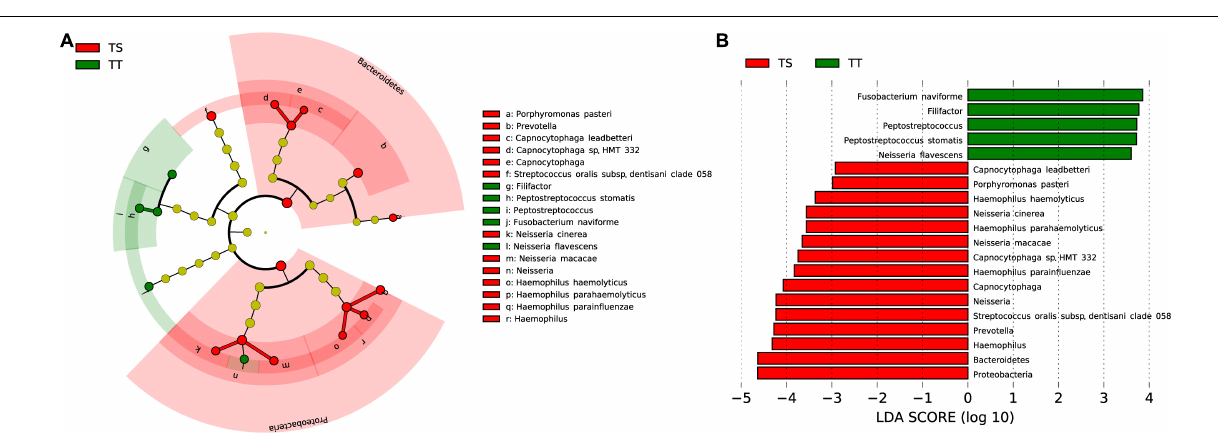
FIGURE 4 | Comparative taxonomic profile of TT and TS groups. (A) The cladogram showed differently enriched taxa. (B) LDA scores computed for differentially abundant taxa between TT and TS groups (Log10 LDA scores > 2). The phyla, genera, and species with significant richness differences (FDR < 0.05) between the two groups are